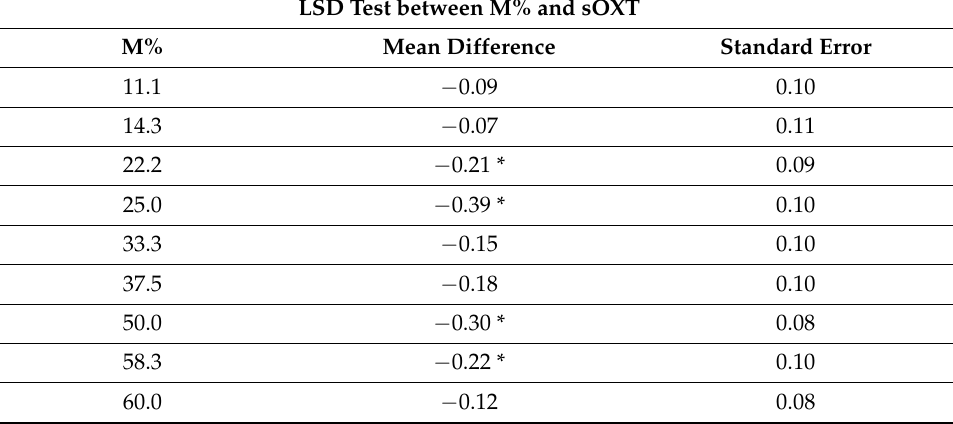
Table 3. Least significant difference (LSD) test between the percentage of male puppies (M%) and salivary oxytocin